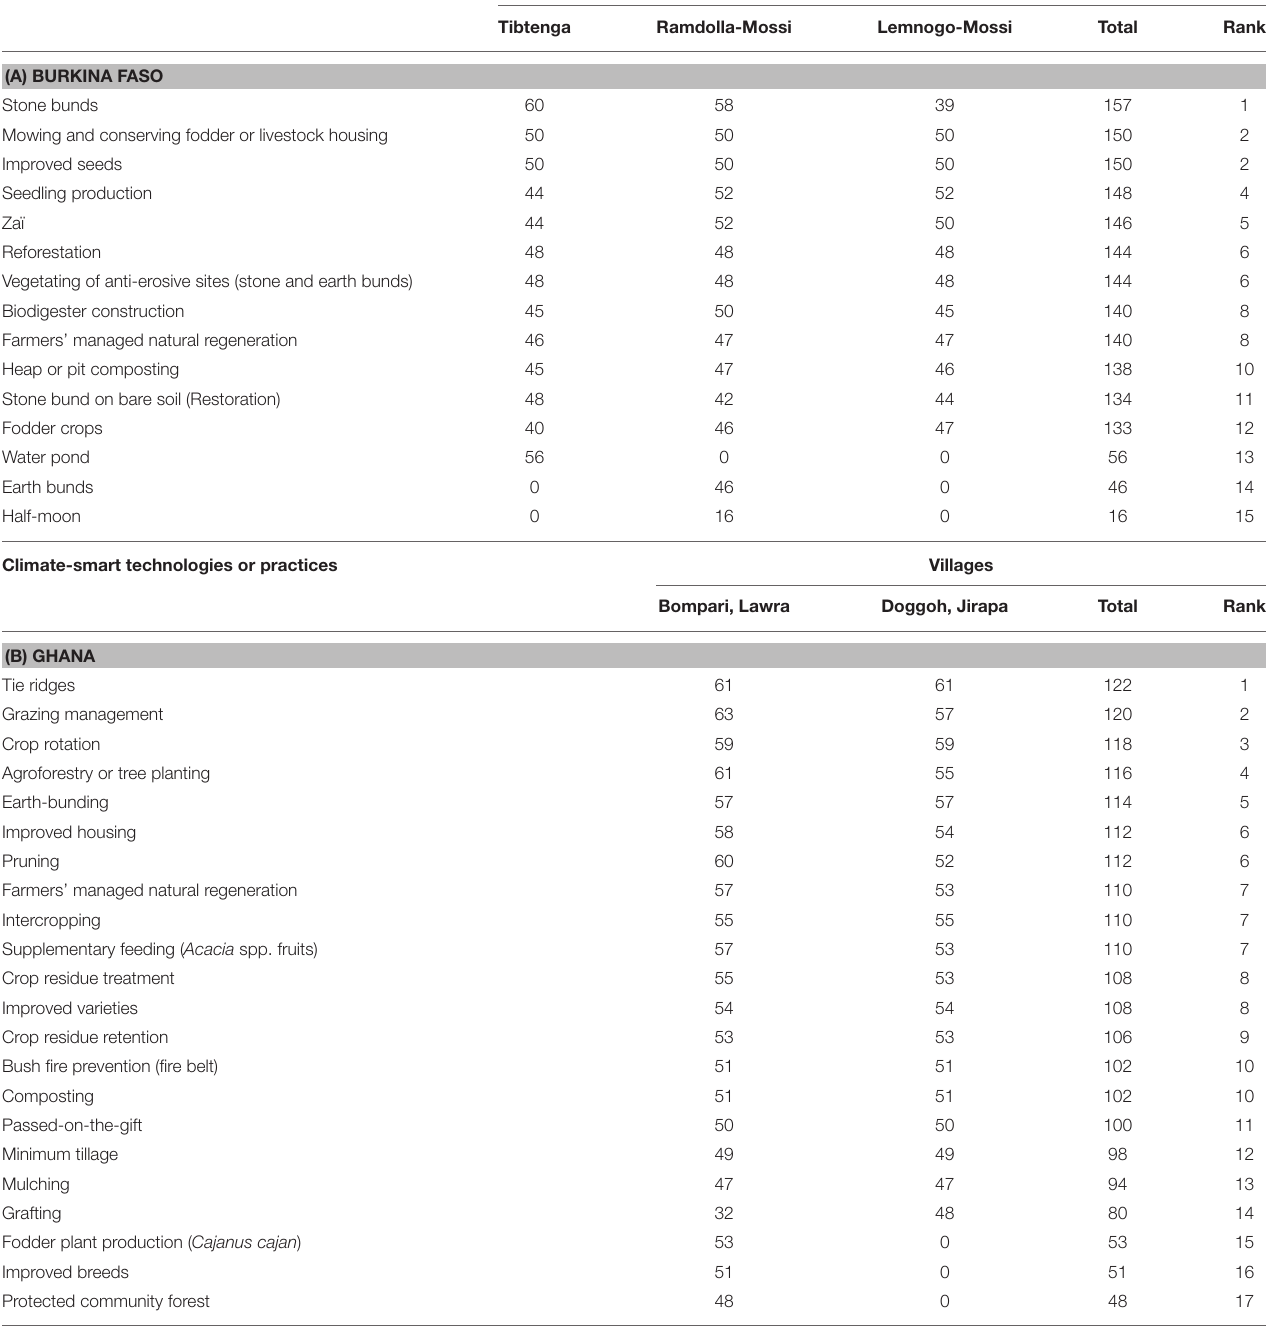
TABLE 2 | Examples of prioritized and ranked climate-smart practices in West Africa. Climate-smart technologies or practices